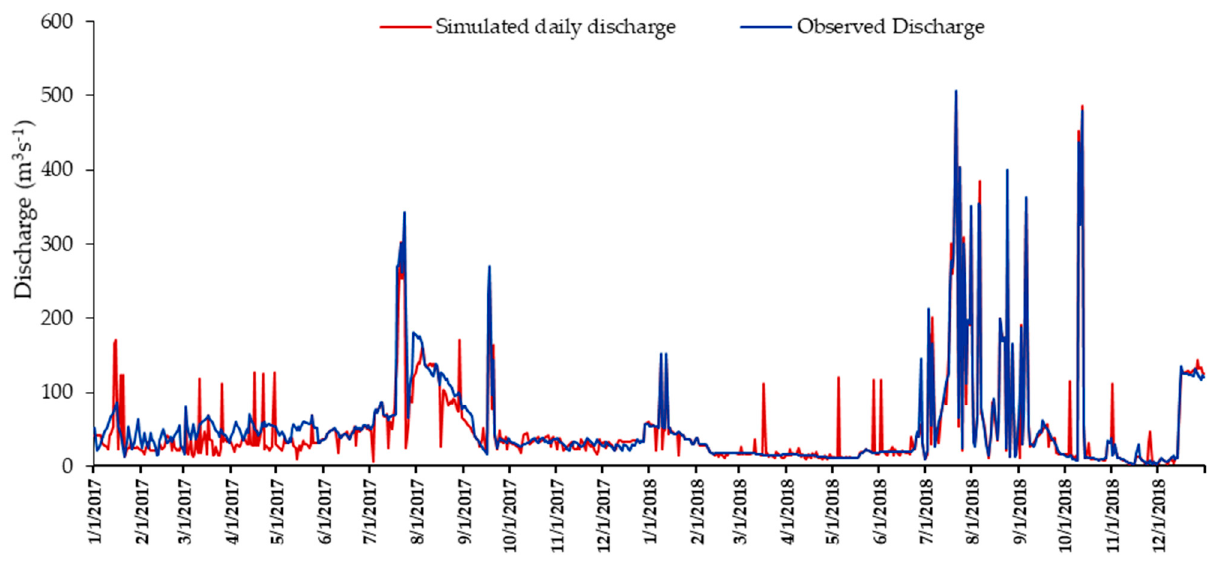
Figure A6. Validation of SWAT simulated discharge with daily observed discharge from Rajghat hydrological station from 2017 to